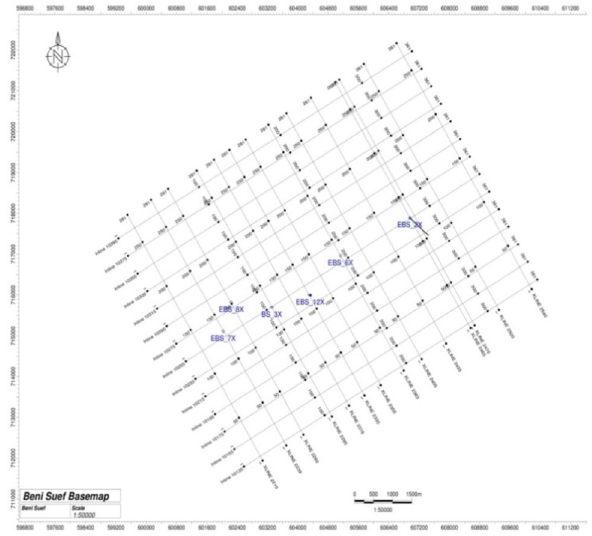
Fig. 3 CDPs and boreholes location